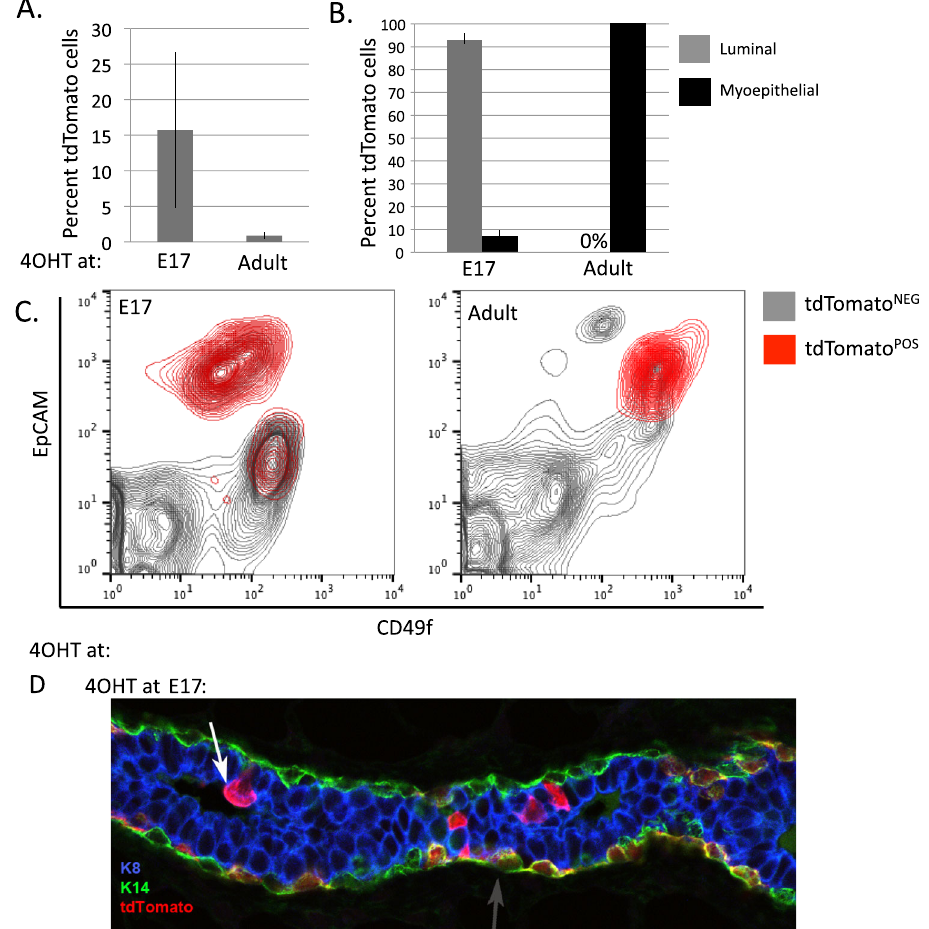
Fig. 3 Lgr5-expressing cells are bipotent in the embryo and lineage restricted in the adult. a – c Lgr5KI; R26 LSL-Tom were injected with 4OHT at stage E17 and adult. Eight weeks later, single-cell suspensions were prepared and viable (DAPI negative) cells were analyzed for expression of the tdTomato fl uorescent reporter, EpCAM, and CD49f. The percentage of cells that were tdTomato positive was measured by designating a threshold above which epithelial cells of R26 WT measured zero. d Lgr5KI; R26 LSL-Tom pregnant mice were injected with 4OHT at stage E17. Eight weeks later, they were harvested, fi xed, sectioned, and stained for Keratin 8 (K8, blue ), Keratin 14 (K14, green ), and tdTomato ( red ). tdTomato co- staining with K8-expressing luminal cells and K14-coexpressing myoepithelial cells are indicated by the white and gray arrows ,